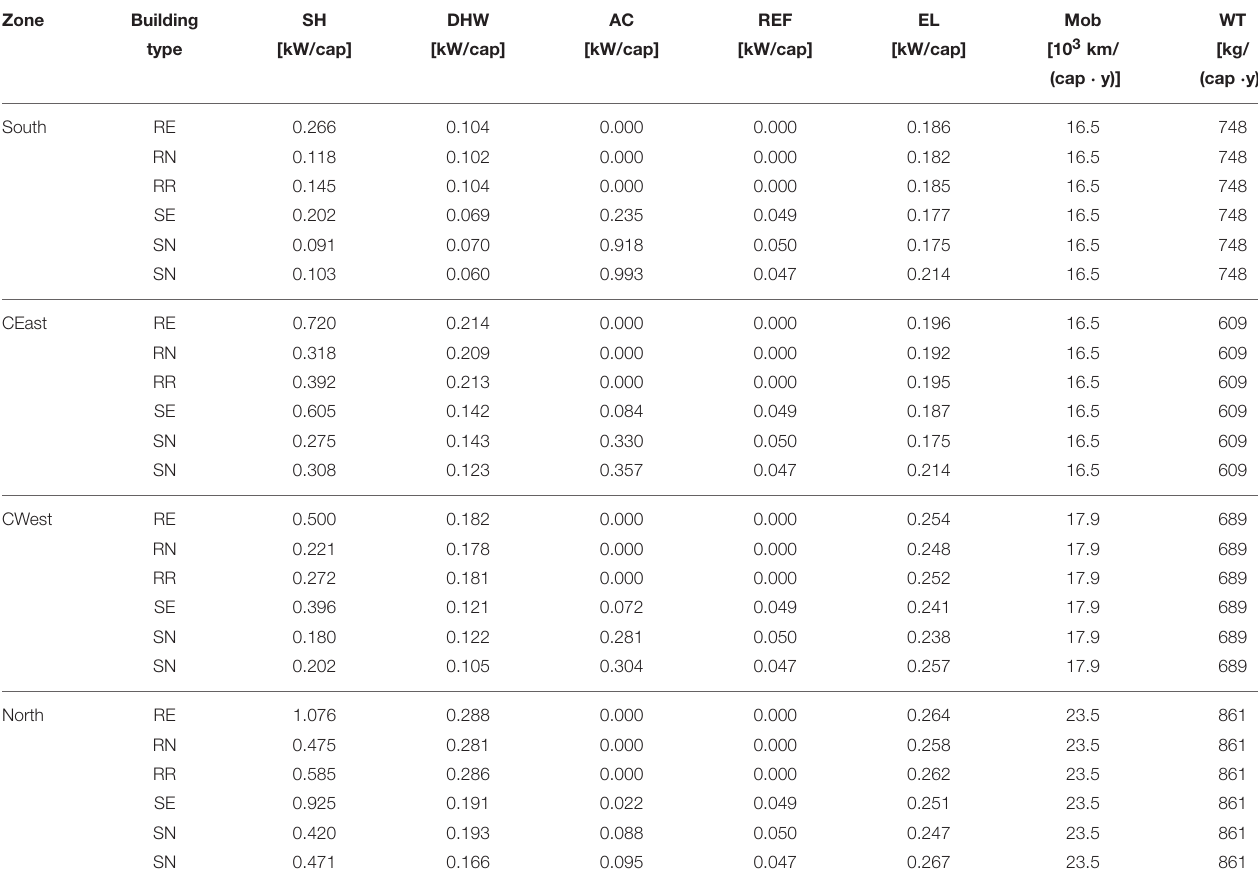
TABLE 4 | Energy demand per capita for different European zones.